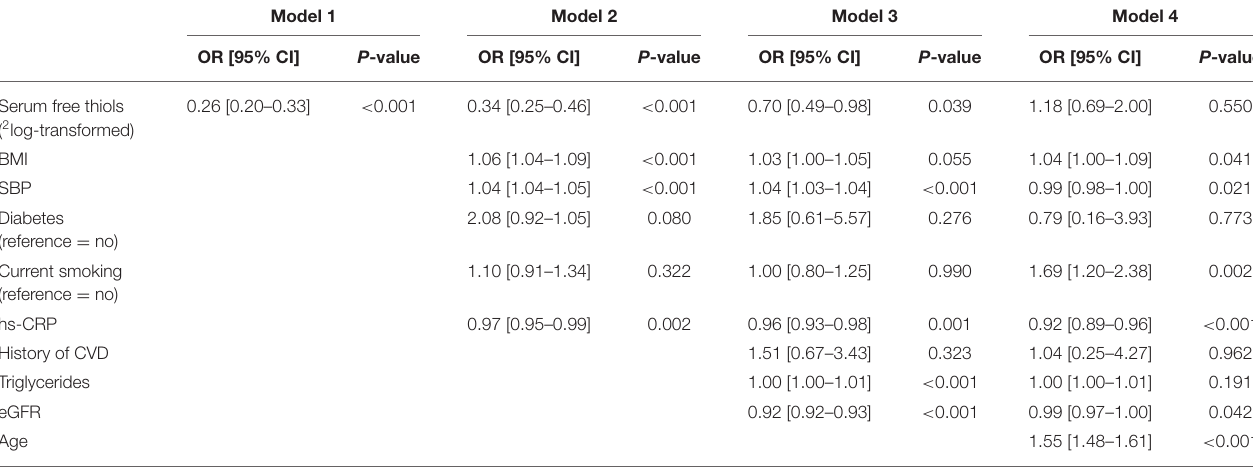
TABLE 3 | Multivariable logistic regression analyses to investigate the association between serum free thiols ( 2 log-transformed) and menopausal status.